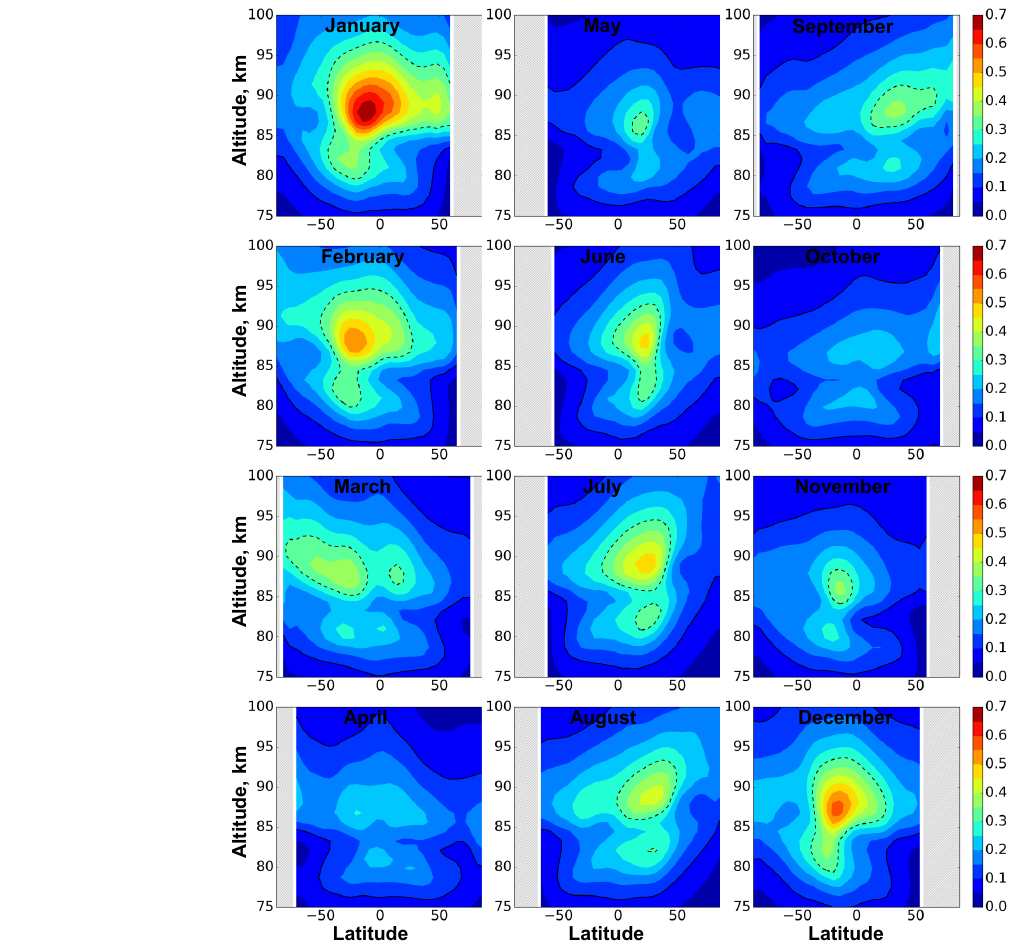
Figure 2. Daytime mean monthly averaged R .